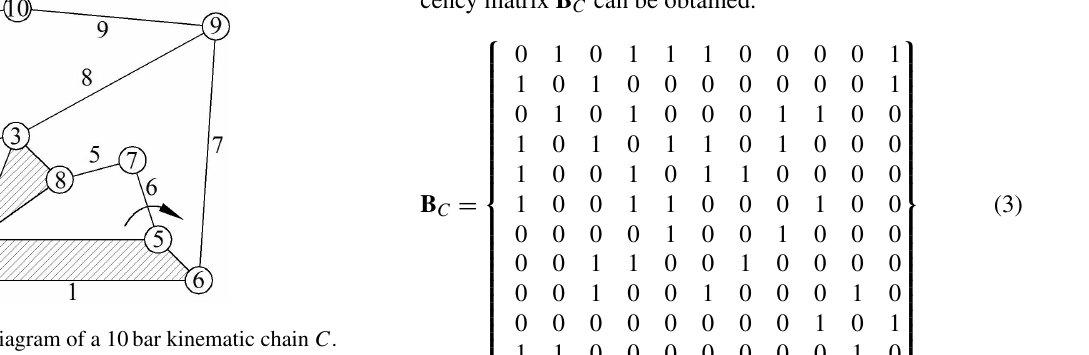
Figure 2. The structure diagram of a 10bar kinematic chain C .